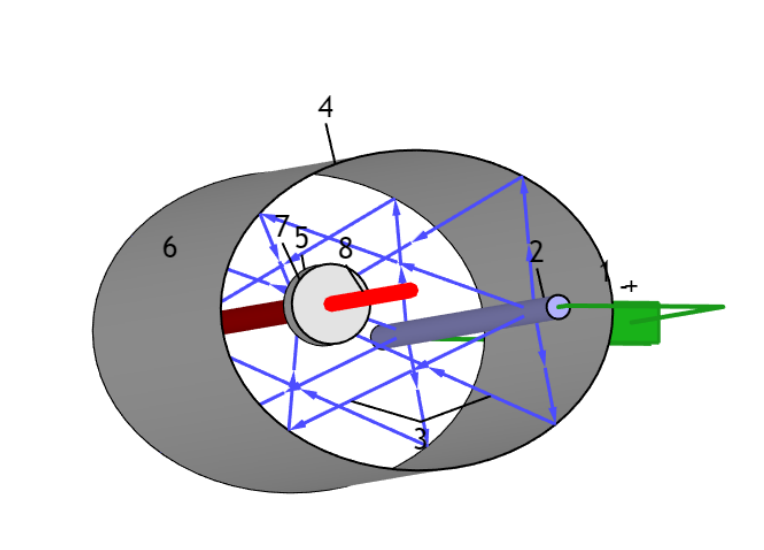
Fig. 3. Elliptical reflector in a solid state